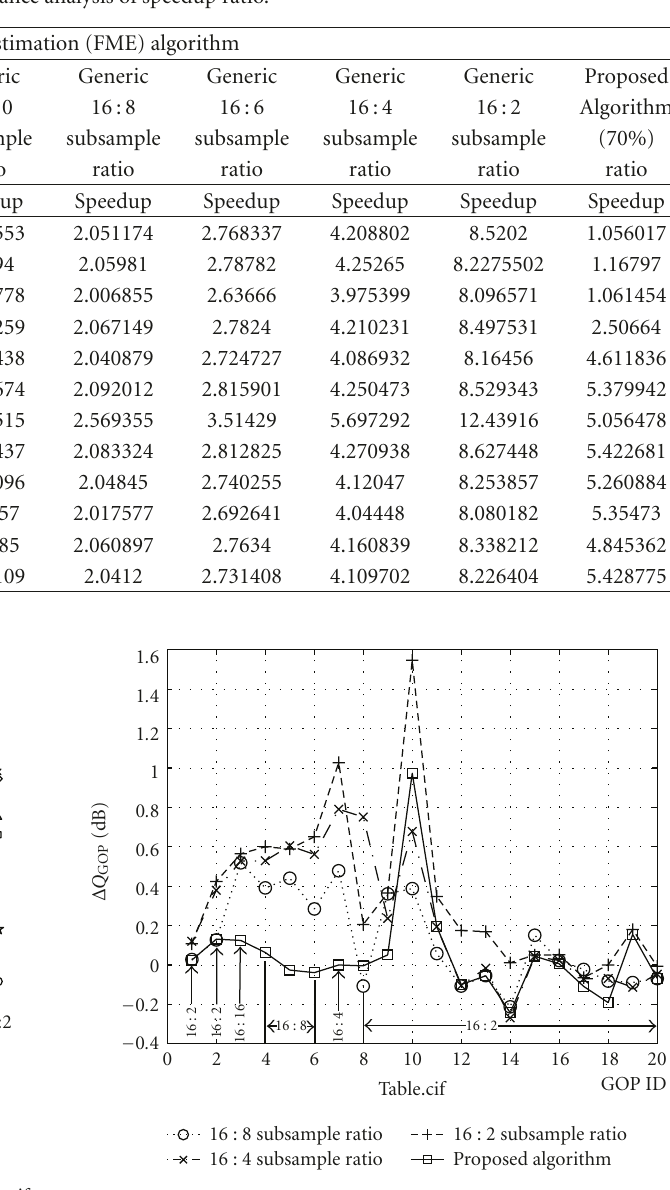
Table 8: Performance analysis of speedup ratio.